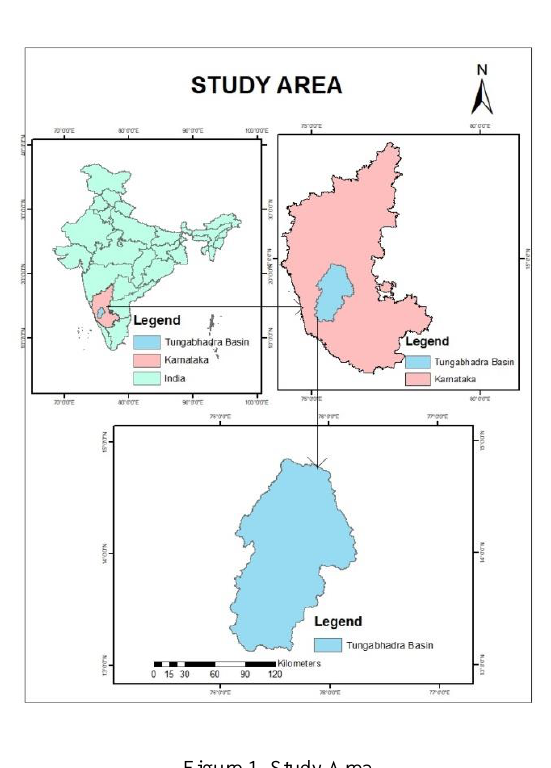
Figure 1. Study Area